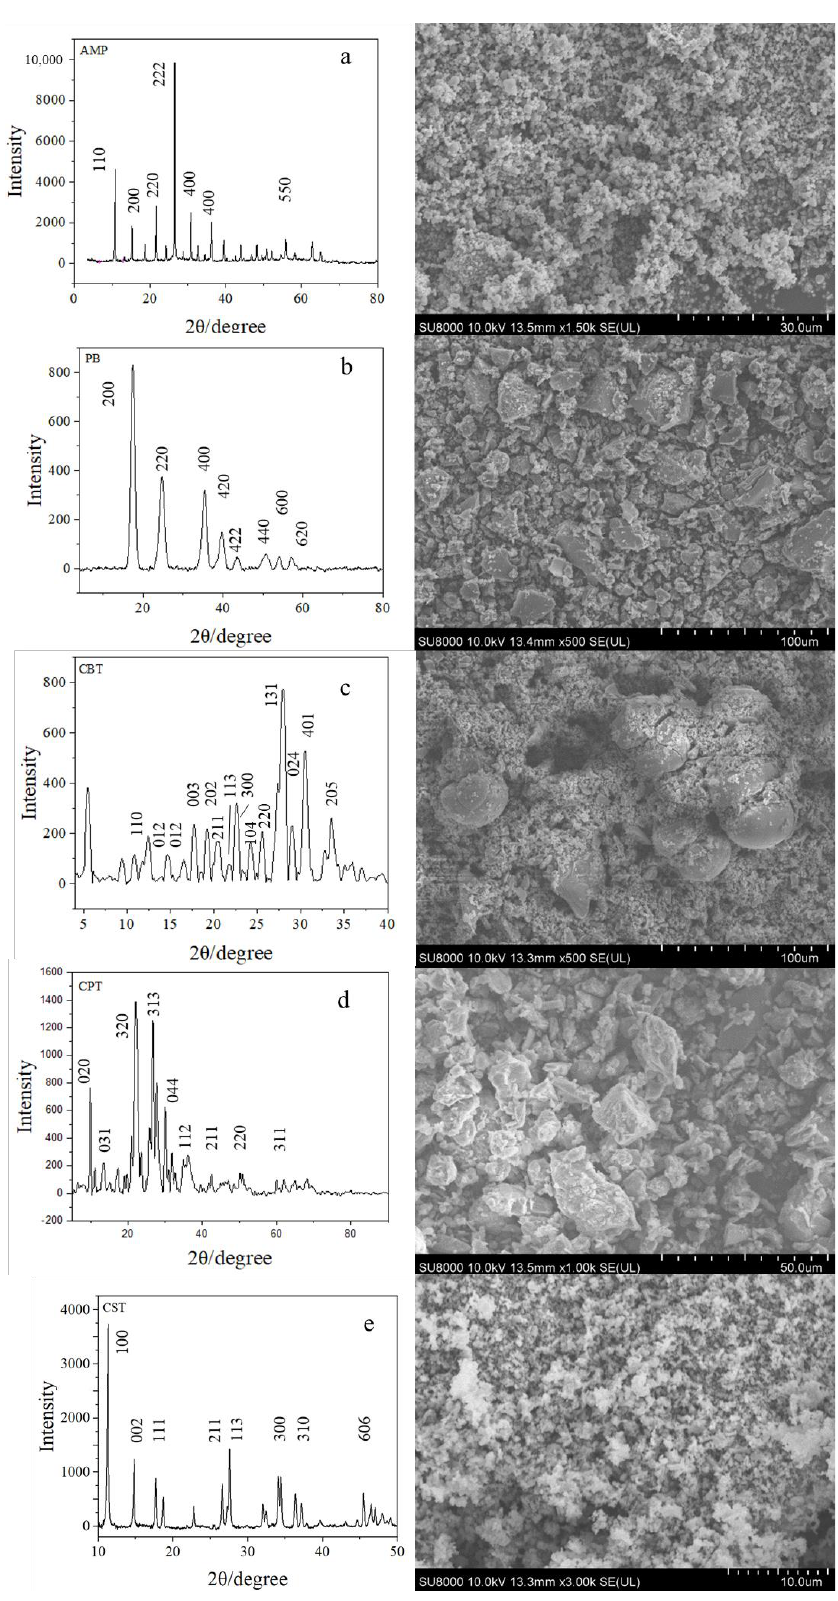
Figure 1. Powder X-ray diffraction patterns and SEM images of as-obtained adsorbents. ( a ). AMP ( b ). PB ( c ). Chabazite ( d ). Clinoptilolite ( e ). Titanium silicate.